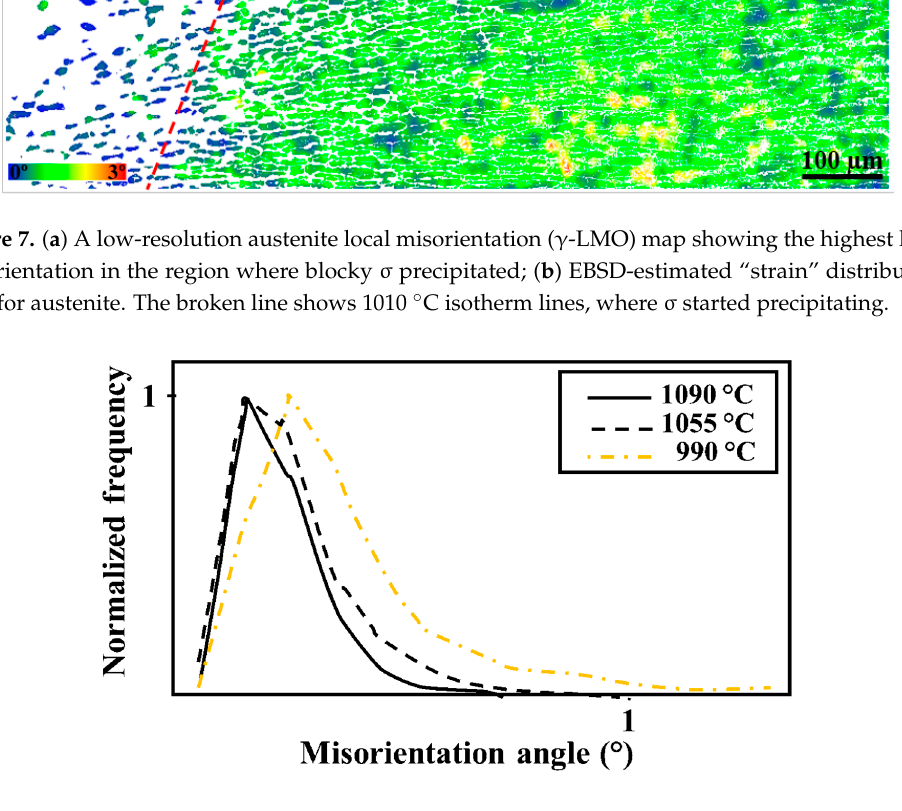
Figure 9. High-resolution γ -LMO maps, where the green areas have higher LMO. γ -LMO is lower in the bulk of primary γ at lower temperatures; however, it is quite high in the γ close to σ /primary γ boundaries.